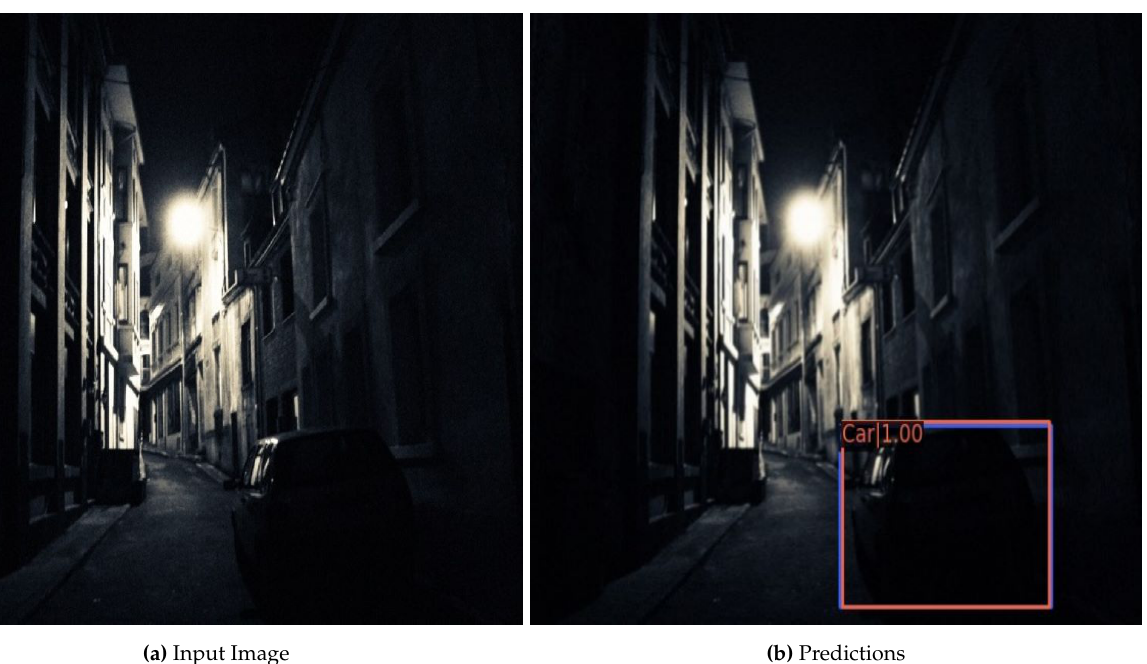
Figure 7. Example of results achieved on the ExDark Dataset. Figure 7a represents an input image, whereas Figure 7b is the final output with the detected object. The blue color represents ground truth annotation, and orange is the network prediction. Table 2. Comparison between the proposed method and previous state-of-the-art results on the RESIDE dataset. AP s denotes average precision for small area, whereas AP m represents average precision for medium area and AP l depicts average precision for large area. The IoU threshold is also defined in the table. Best results are highlighted.